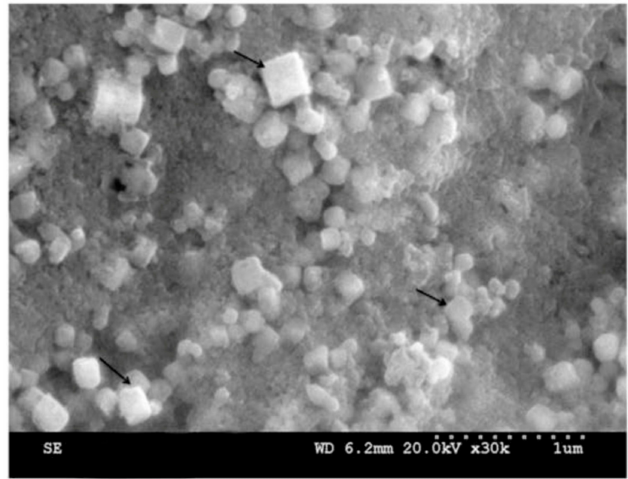
Figure 4. SEM images of Ag-NP obtained using aqueous leaf extract of Melia azedarach [97].